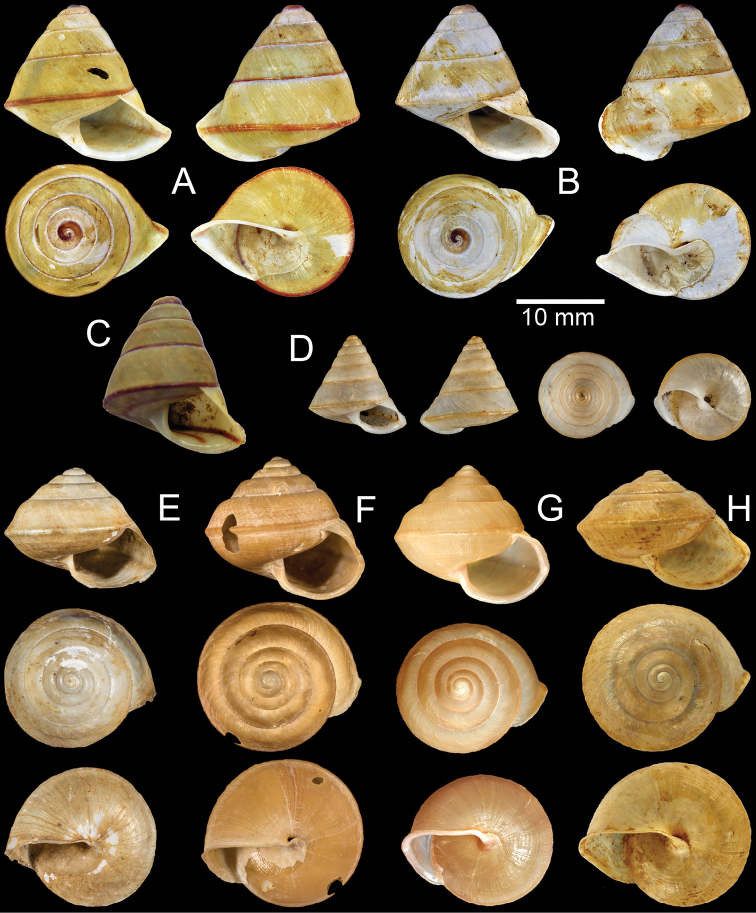
A–CGanesella
halabalah sp. nov. A holotype CUMZ 2608 B paratype CUMZ 2599 from the type locality and C paratype ZMB 53120 from Kelantan, Malaysia DGanesella
perakensis, syntype MNHN-IM-2000-1964. E–GGlobotrochus
onesteraE lectotype MNHN-IM-2000-32456 F holotype of “simonei Thach & Huber, 2017” MNHN-IM-2000-33206 and G specimen from Vietnam CUMZ 5218 HGlobotrochus
mellea, holotype RBINS/MT/ 525051.